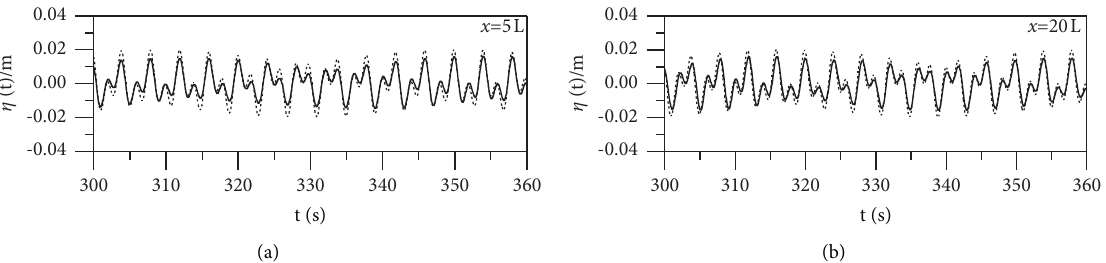
Figure 7: Comparisons of the wave profiles between the calculation results (solid line) and theoretical results (dashed line) at different gauge locations for case D2.